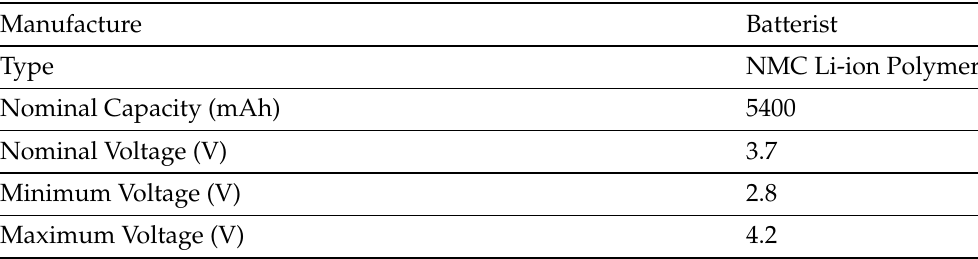
Table 1. Battery cells